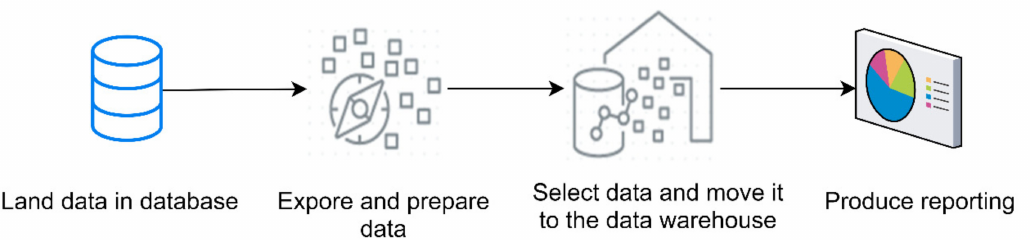
Figure 4. The overview of the data flow in a data warehouse.